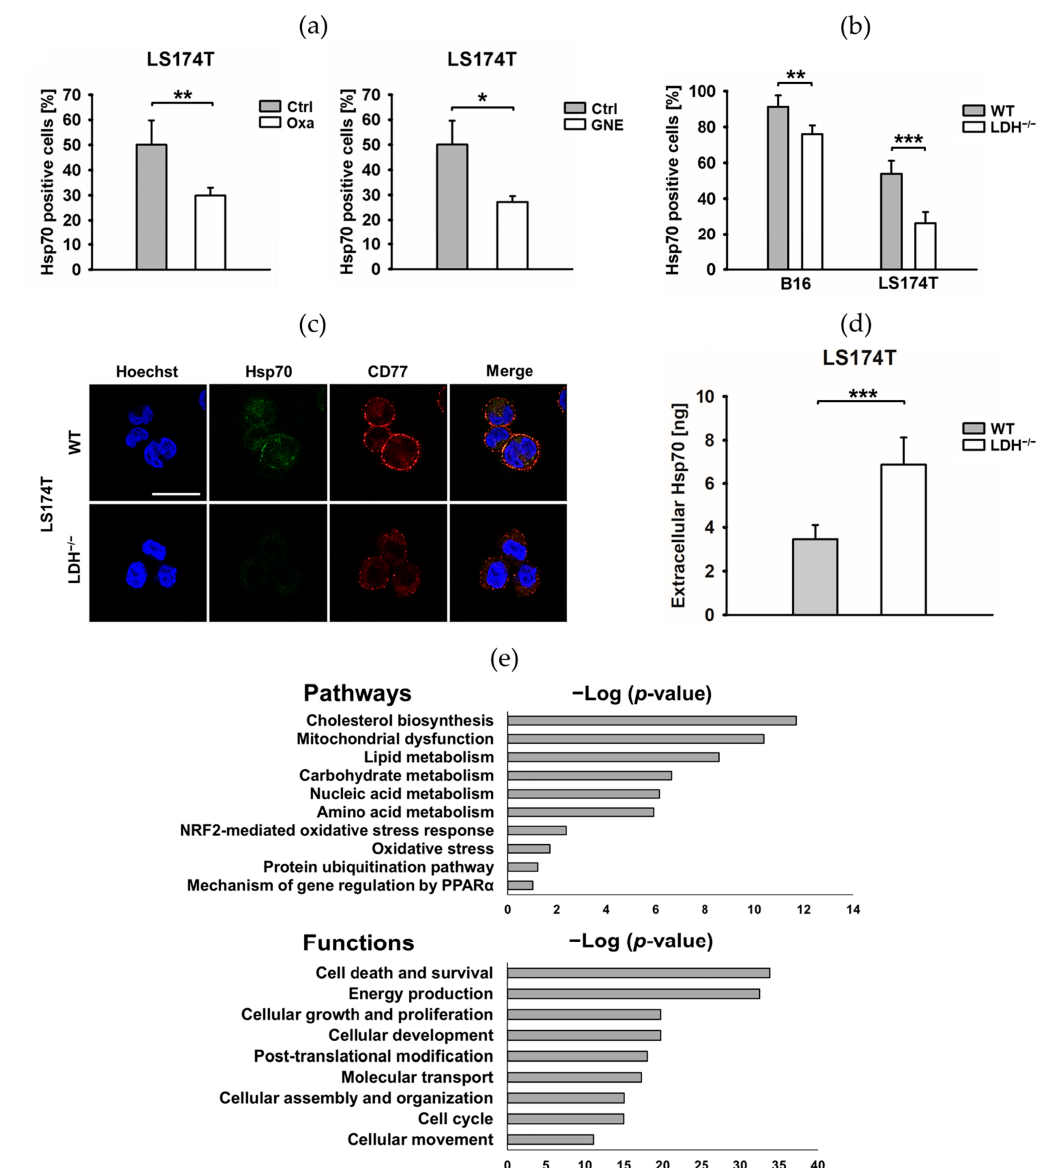
Figure 4. The lactate dehydrogenase (LDH) inhibition by oxamate (Oxa) and GNE-140 (GNE) and a LDHA/B double knockout (LDH − / − ) results in a reduced heat shock protein 70 (Hsp70) and globotriaosylceramide (Gb3) expression on the cell membrane. ( a , b ) Membrane-bound Hsp70 on untreated (Ctrl) and Oxa- or GNE-treated LS174T tumor cells ( a ) and membrane-bound Hsp70 on B16F10 and LS174T cells ( b ), as determined by flow cytometry using cmHsp70.1-FITC mAb. The proportion of positively stained cells is shown. Error bars show the standard deviations (SD) of at least three biological replicates (*: p ≤ 0.05, **: p ≤ 0.01 and ***: p ≤ 0.001). ( c ) LS174T cells stained for the expression of membrane Hsp70 (cmHsp70.1-FITC mAb, green) and Gb3 (CD77-PE mAb, red) were analyzed by confocal microscopy. The colocalization of Hsp70 and Gb3 is visualized in yellow as a merge of the red and green staining. Scale bar: 5 µ m. ( d ) Extracellular Hsp70 levels in the supernatant of the LS174T cells were measured by ELISA and the data normalized to 1 × 10 6 viable tumor cells. Error bars show the SD of five biological replicates (***: p ≤ 0.001). ( e ) Proteome profiling of LS174T WT and LDH − / − cells. The most significant canonical pathways and top molecular functions altered by LDH depletion are illustrated. The analyses were generated through the use of Ingenuity Pathway Analysis (IPA) (QIAGEN Inc., https://www.qiagenbio-informatics.com/products/ingenuity-pathway-analysis, accessed on 22 April 2021). Bars indicate the canonical pathways, and the y -axis displays the − (log p ) enrichment significance. NRF2: nuclear factor erythroid 2–related factor 2, PPAR α : peroxisome proliferator-activated receptor